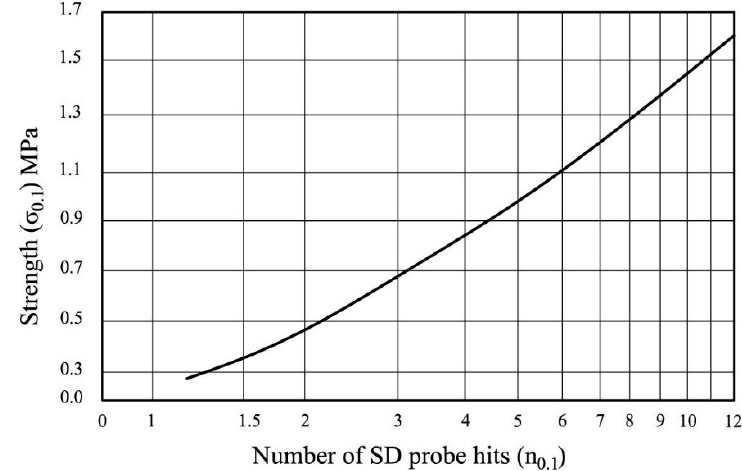
Figure 4. The relationship between the strength σ 0.1 and the number of SD probe hits (n 0.1 ) per the depth of 0.1 m of the probe needle drive [34].